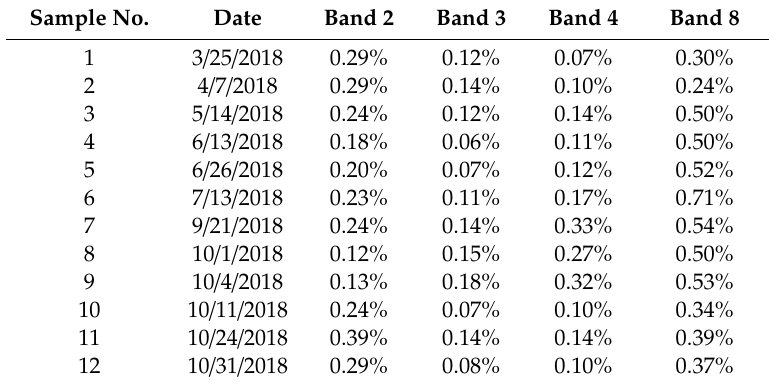
Table 5. Combined uncertainty of the predicted TOA reflectance caused by atmospheric parameters in bands 2, 3, 4, and 8 of Sentinel-2B / MSI.